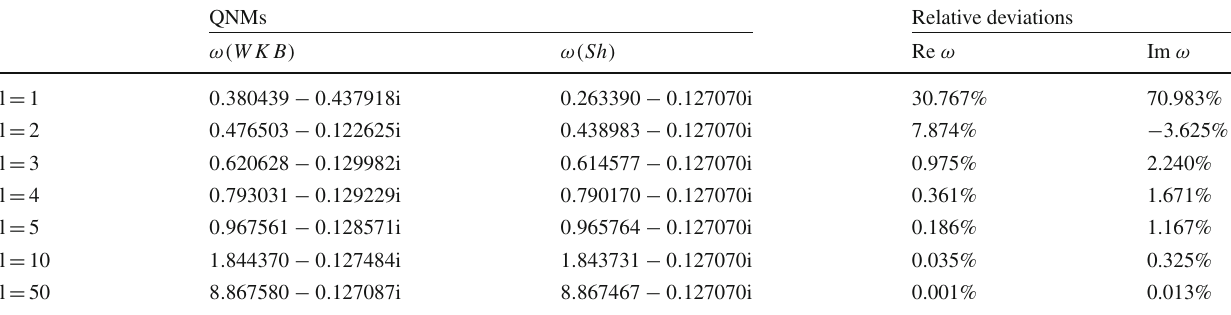
Table 8 The QNMs derived by the WKB approximation approach and shadow radius and the relative deviations. In the calculation, we let Q = 0 . 7